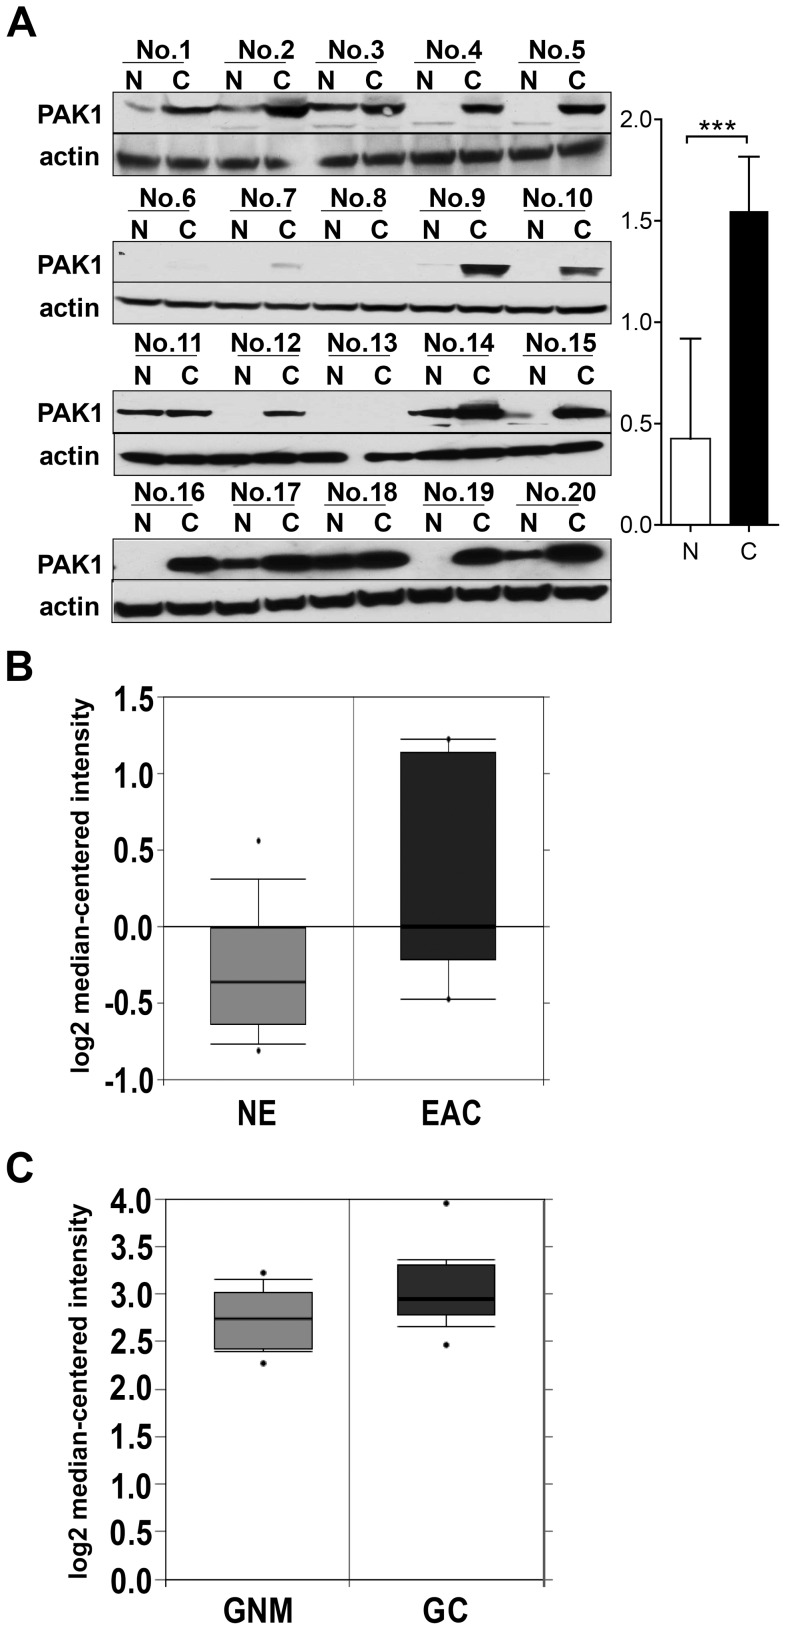
Upregulated PAK1 in GEJ adenocarcinoma.(A) PAK1 protein levels were determined by immunoblot analysis in human GEJ adenocarcinoma tissues (C; n = 20) vs. adjacent noncancerous tissues (N; n = 20); ***P<0.001. PAK1 mRNA levels in esophageal adenocarcinoma (B) and gastric cancer (C) were analyzed using the ONCOMINE database (http://www.oncomine.com). NGM, normal gastric mucosa (n = 12); GC, gastric cancer (n = 12); NE, normal esophagus (n = 24); EAC, esophageal adenocarcinoma (n = 9).